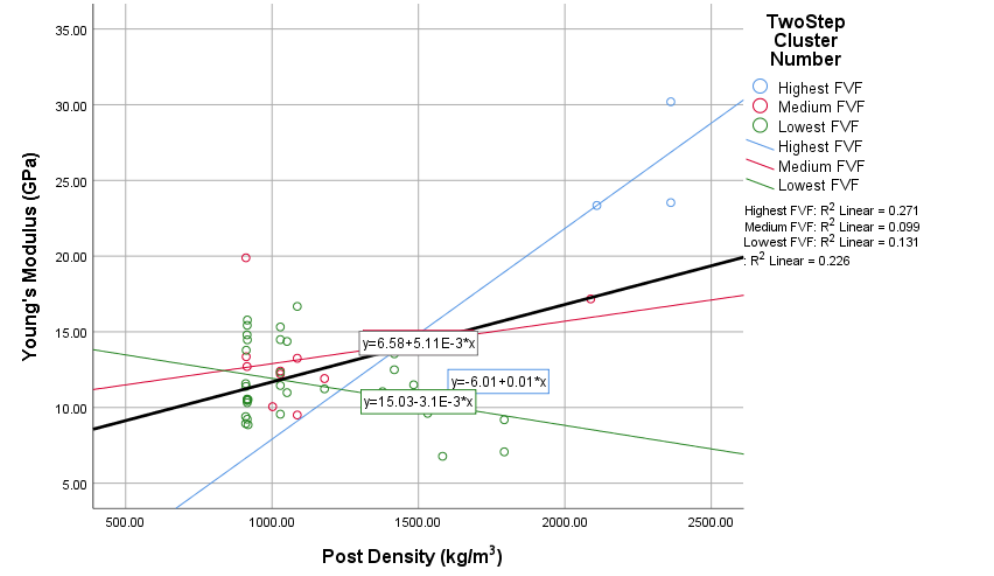
Figure 13. The relationship between fiber mass and Young’s modulus.